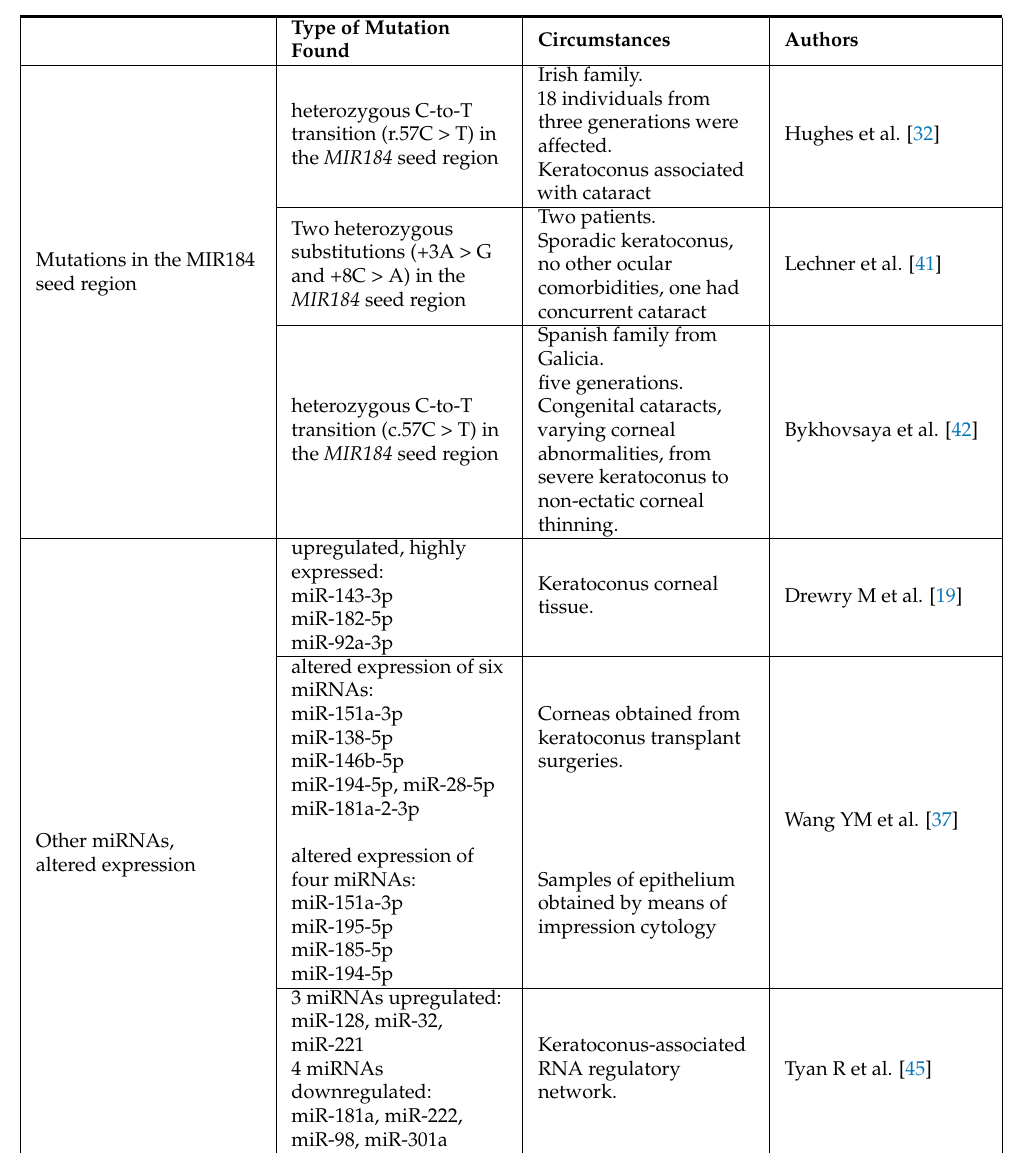
Table 1. miRNAs in